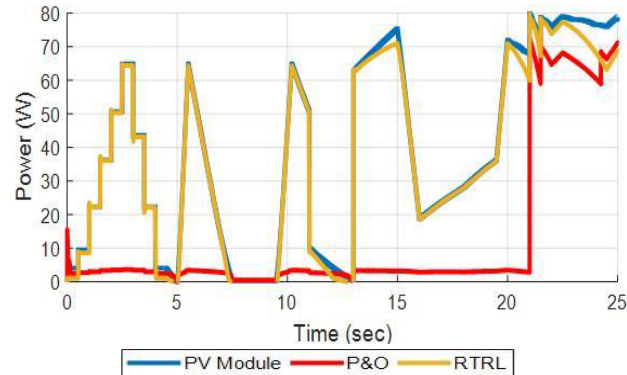
Figure 18. Variable irradiance and temperature signals for a simulation time of 25 s.